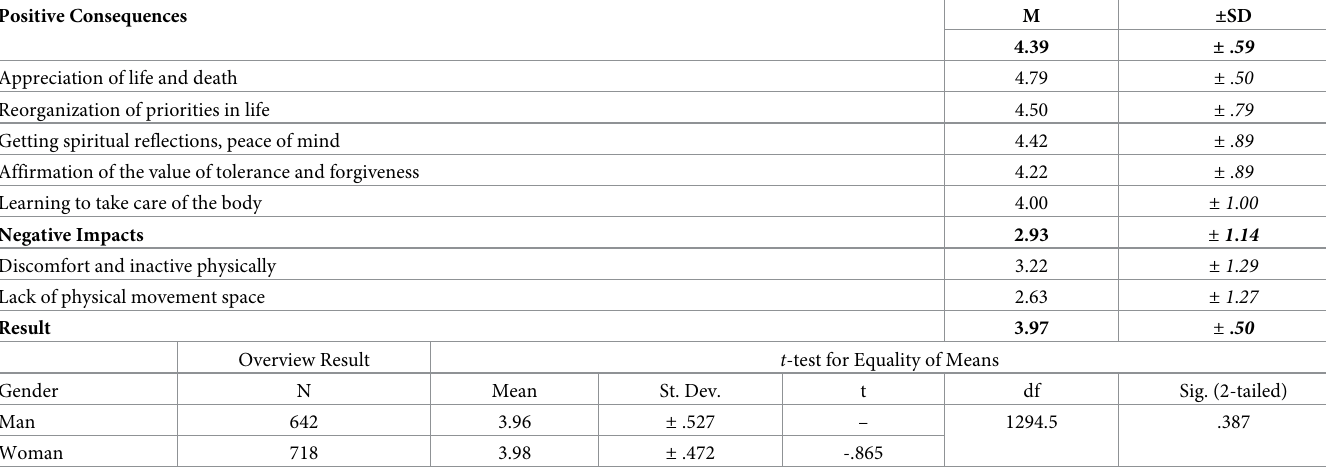
Table 5. Descriptive statistics for the impacts of COVID-19 on spiritual and physical aspects of students’ lives.